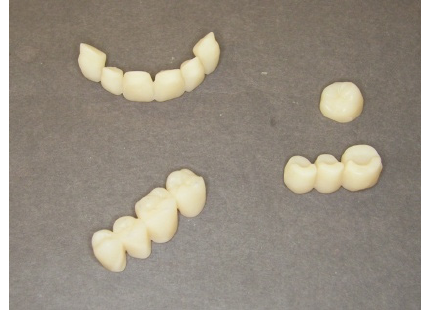
Figure 19. Milled denture teeth.